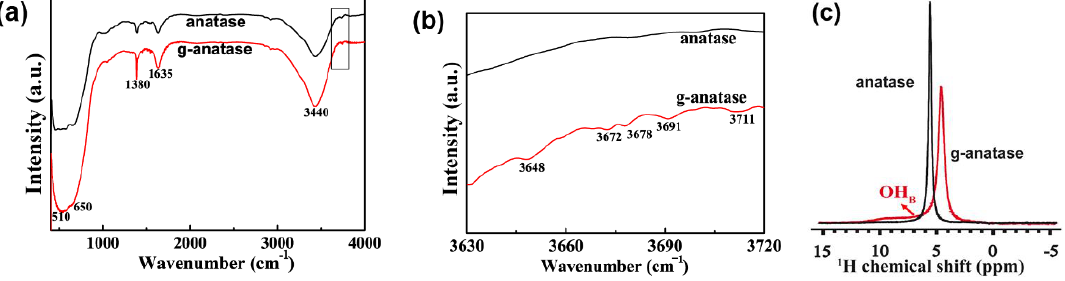
Figure 6. ( a , b ) FT-IR spectra and ( c ) 1 H solid-state NMR spectra of anatase and colored anatase.